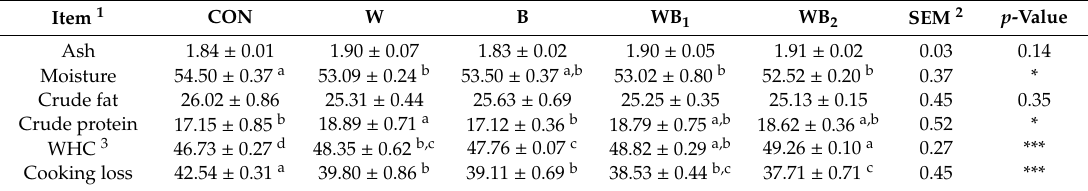
Table 2. Proximate composition (%) analysis, WHC (%), cooking loss (%) of pork patties formulated with Boswellia serrata and whey